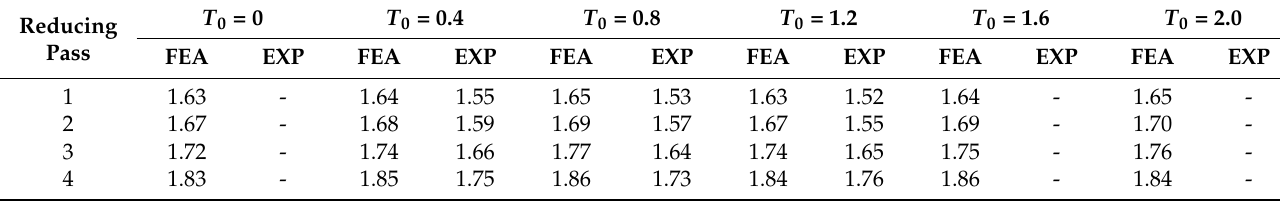
Table 6. End warpage of reduced tube (mm).